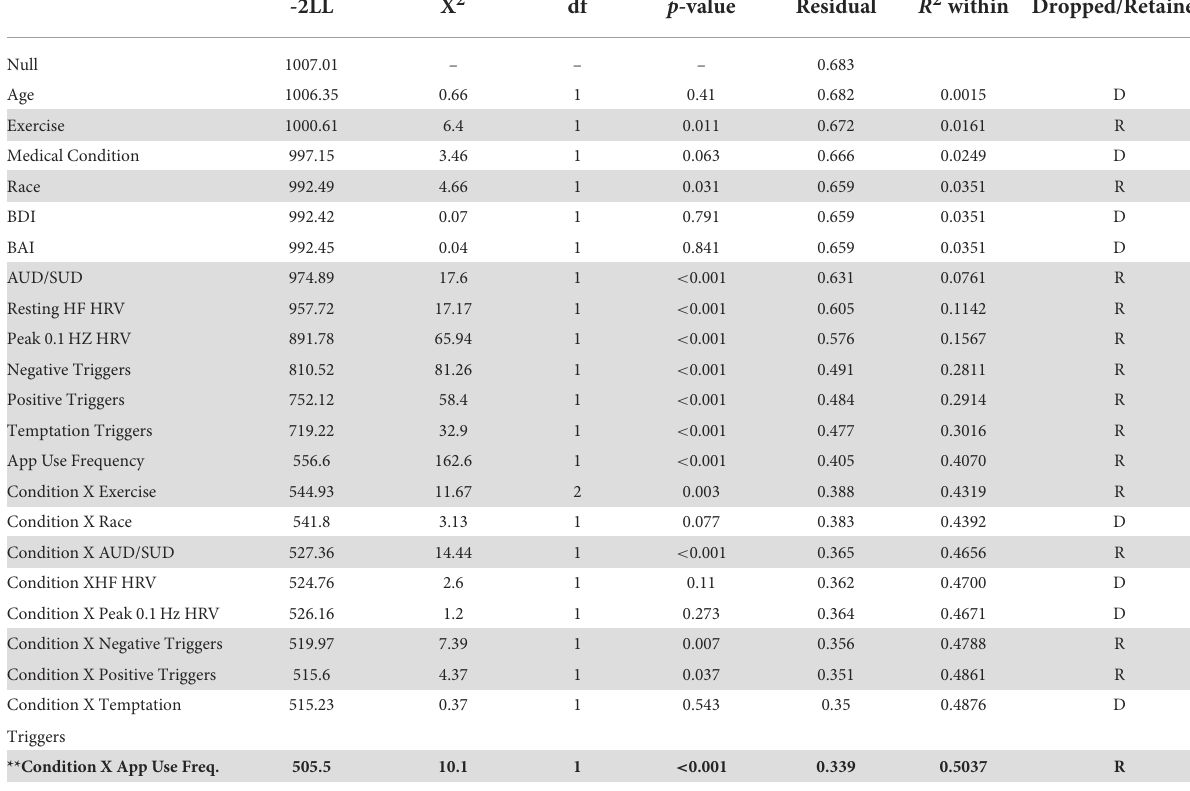
TABLE 1B Model fit statistics (compared to previous row):